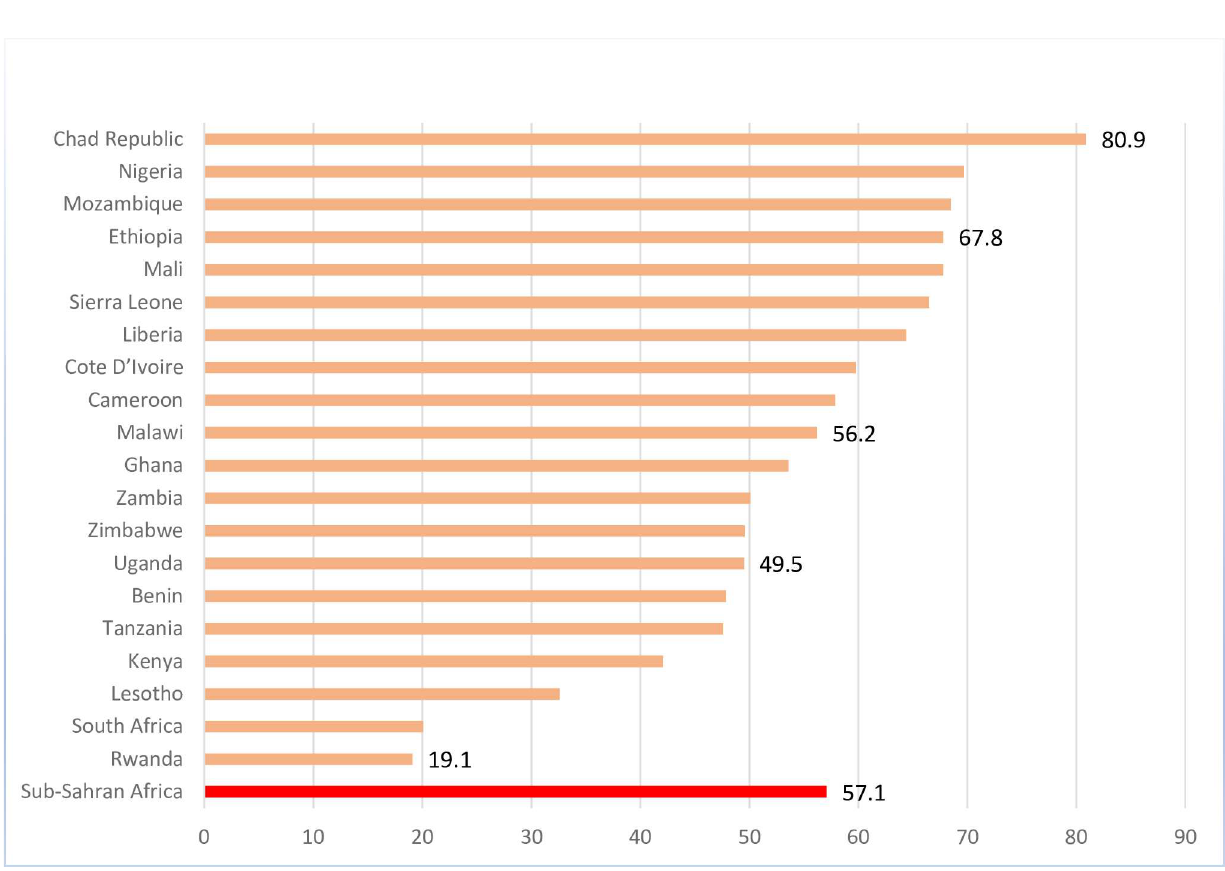
Fig 1. Percentage of child-brides across selected SSA